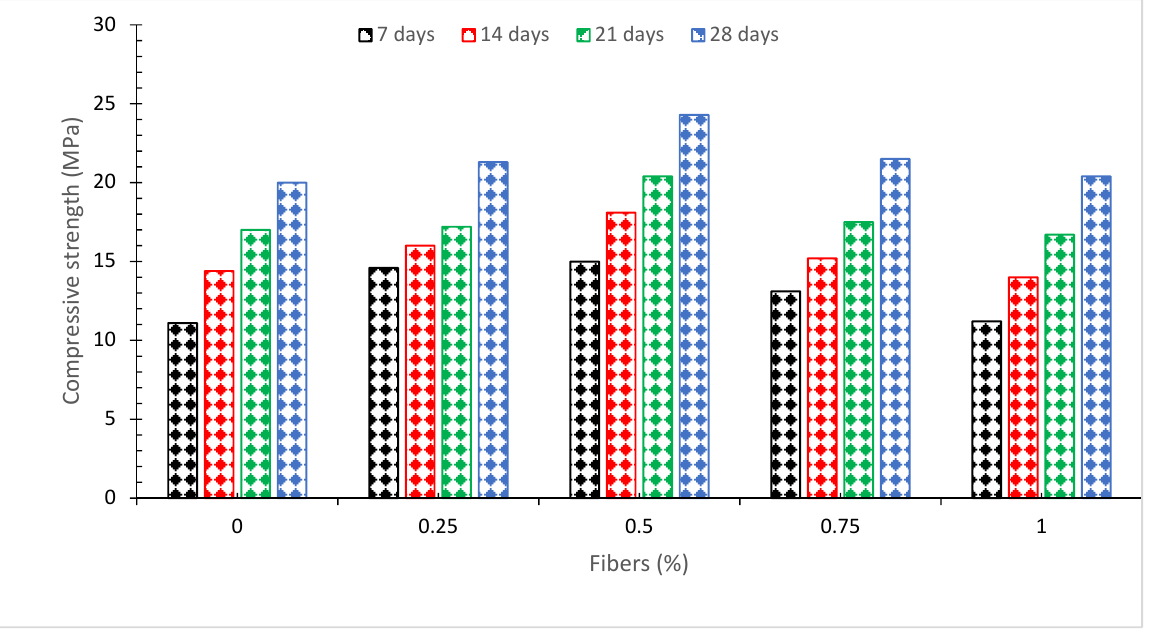
Figure 4. Compressive strength [48].